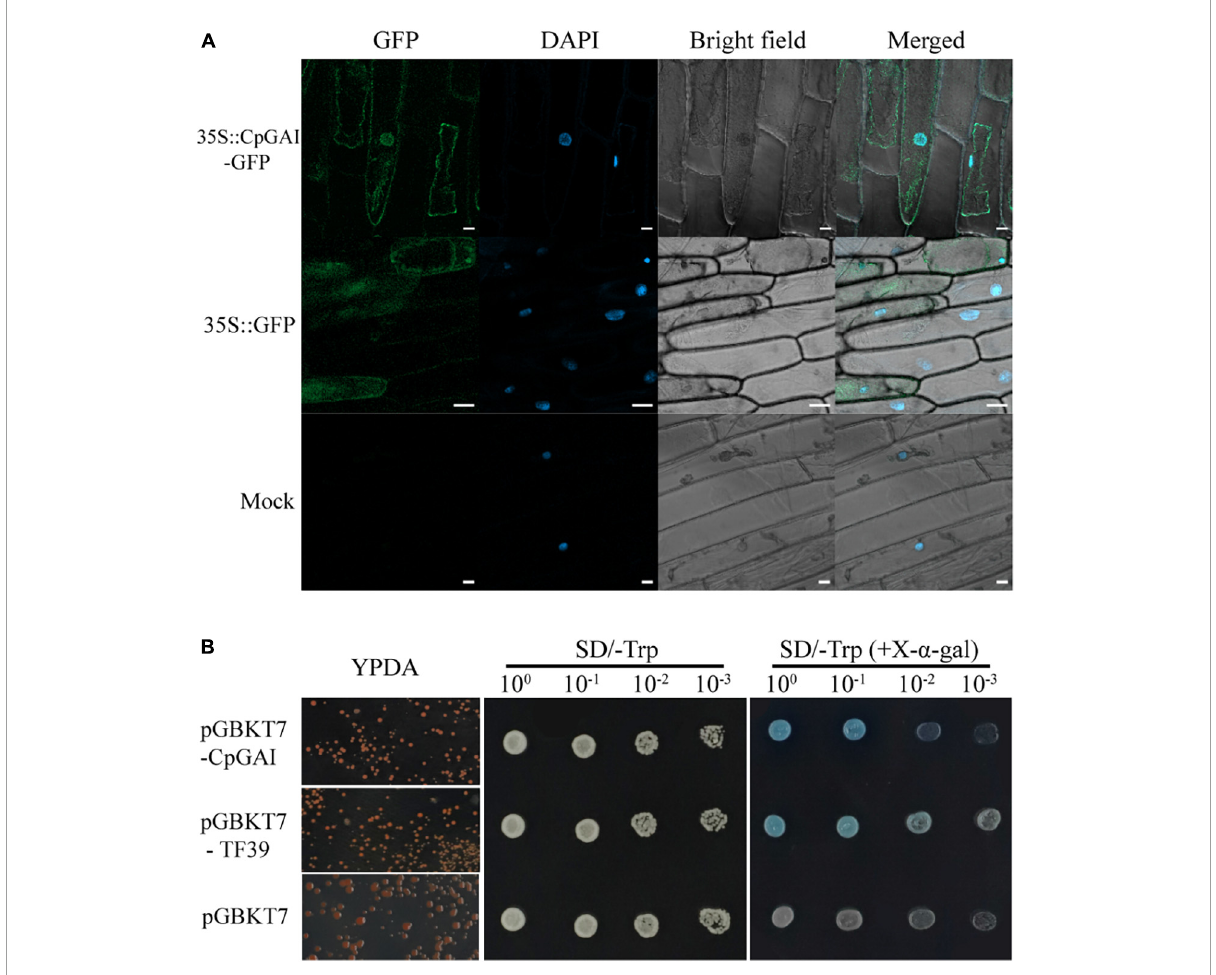
FIGURE7 CpGAI is mainly located in the nucleus and has transcriptional self-activation activity. (A) Subcellular localization of CpGAI-GFP in onion epidermis. The short white line at the lower right of 35S:CpGAI-GFP , 35S: GFP , and mock represents 20, 50, and 20 µ m, respectively. (B) Transcriptional self-activating activity of CpGAI protein in yeast cells. SD/-Trp, medium without tryptophan; SD/- trp (+ X - α -gal), medium without tryptophan containing 5-bromo-4-chloro-3-indoxyl- α - D -galactopyranoside. pGBKT7-TF39 is the positive control, and pGBKT7 is the negative